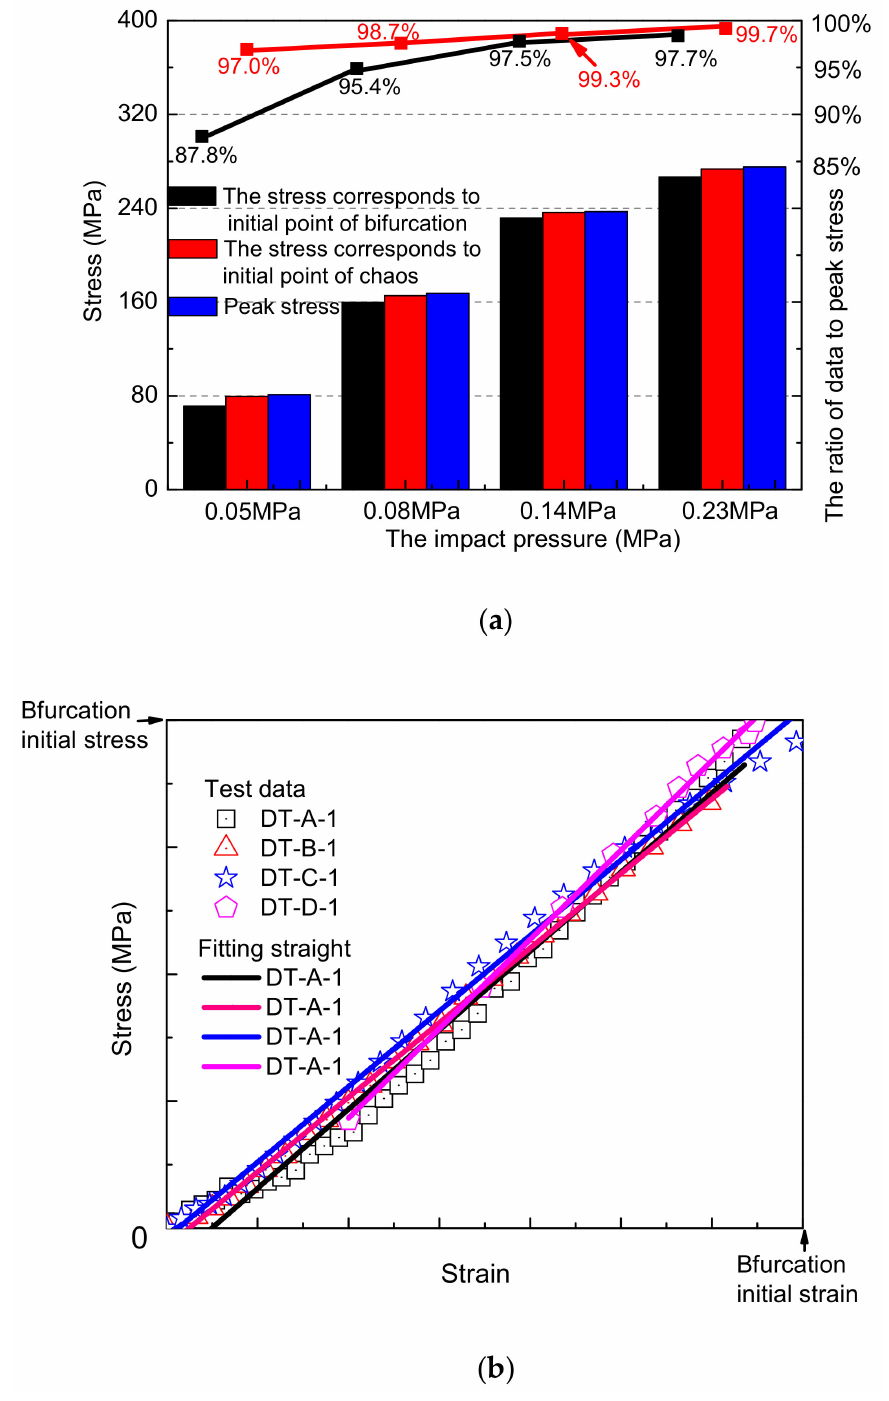
Figure 8. The chaotic characteristics of rock damage evolution: ( a ) influence of loading speed on chaotic characteristics of samples; ( b ) similarity of damage